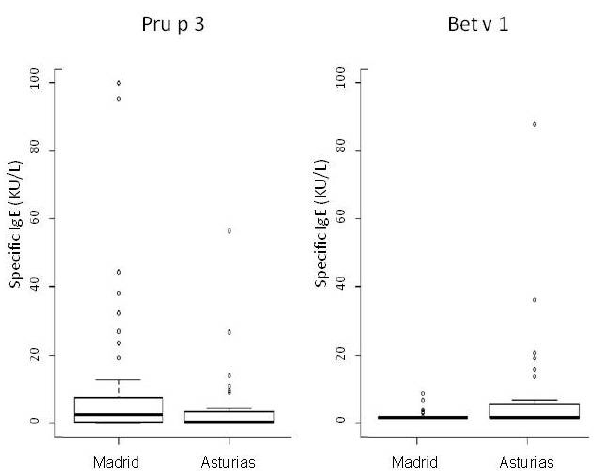
Figure 2. Specific IgE to LTP (Pru p 3) and Bet v 1 from both regions (median, Q1, and Q3). Table 7. Differences in specific IgE levels to purified allergens between Madrid and Asturias (Median, Q1, Q3).